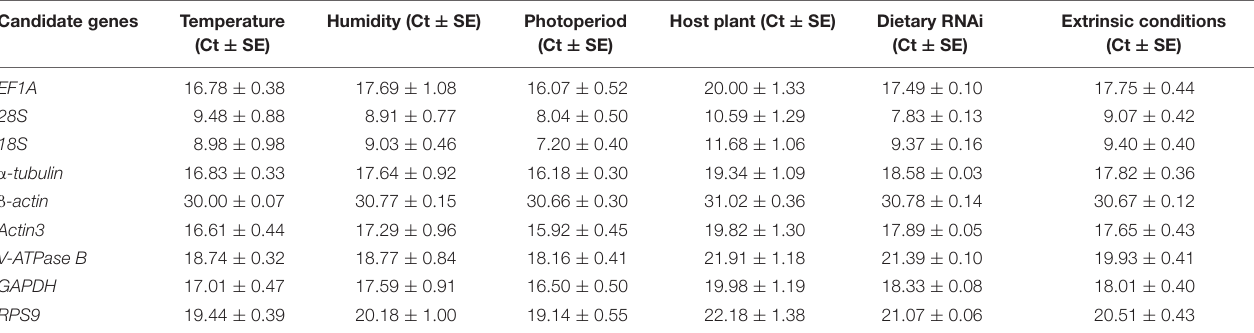
TABLE 1 | Ct values of candidate reference genes under different extrinsic